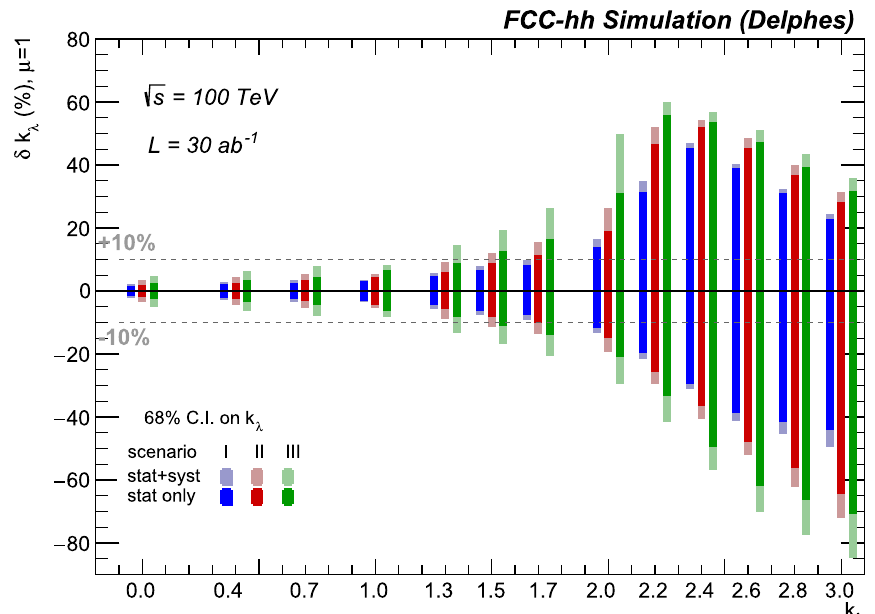
Fig. 15 Expected precision on the Higgs self-coupling as a function of the κ λ value for each scenario. To improve readability, the positions of scenario I (III) bands are slightly offset in the negative (positive) direction along the κ λ